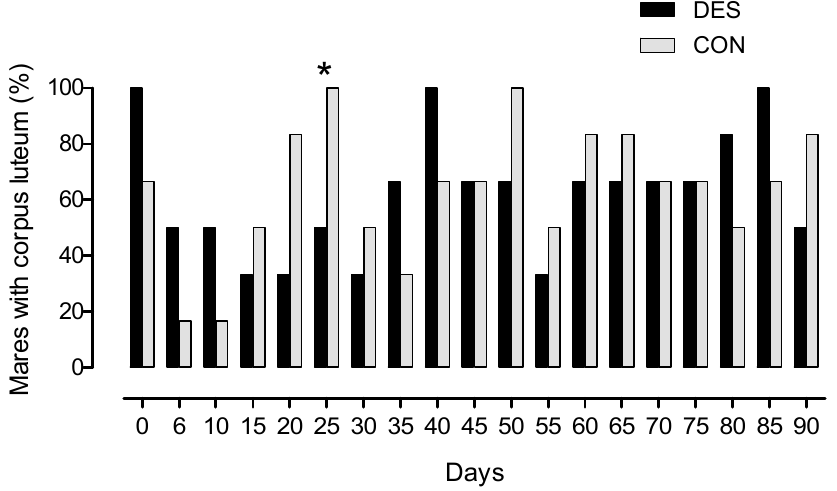
Figure 1. Percentage of mares with corpus luteum (%) in group DES (9.4 mg slow-release deslorelin; black columns, n = 6) and group CON (1.25 mg short-acting deslorelin, grey columns, n = 6), * indicates significant difference between groups ( p < 0.05).